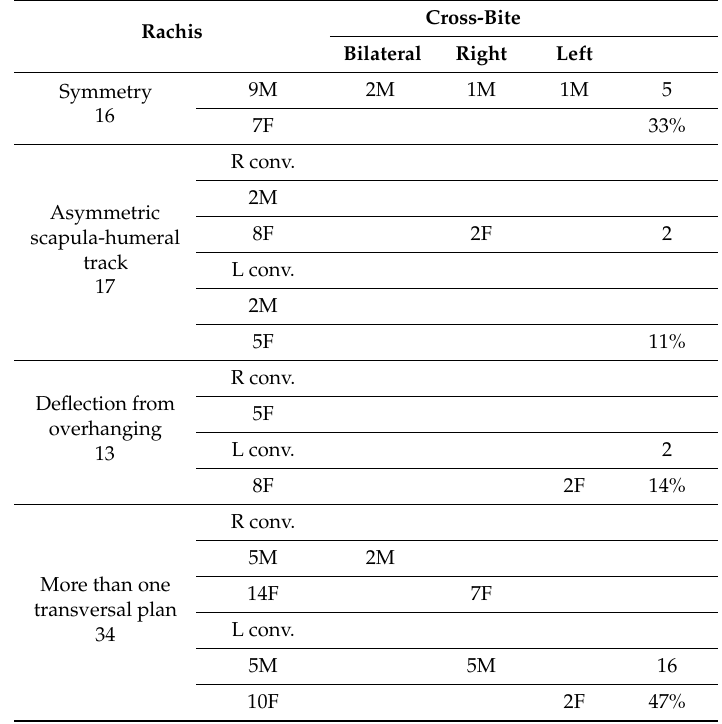
Table 4. Relations between di ff erences in transversal planes and cross-bite in our sample. Cross-Bite Rachis Bilateral Right